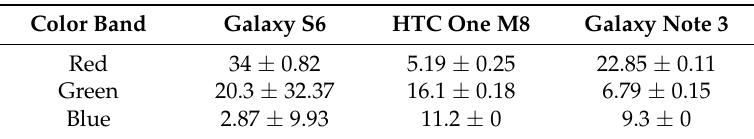
( c ) ( f ) Figure 15. Box plot of the average values of 𝑖 ∗ of the three color bands obtained from the 64 ROIs of Figure 15. Box plot of the average values of i ∗ of the three color bands obtained from the 64 ROIs of the the Galaxy S6 and the Galaxy Note 3 from 30 subjects with flash off: (a) Red (Galaxy S6); ( b ) Green Galaxy S6 and the Galaxy Note 3 from 30 subjects with flash off: ( a ) Red (Galaxy S6); ( b ) Green (Galaxy (Galaxy S6); ( c ) Blue (Galaxy S6); ( d ) Red (Galaxy Note 3); ( e ) Green (Galaxy Note 3); ( f ) Blue (Galaxy Note 3). Table 4. The average values of i ∗ of the three color bands obtained from 64 ROIs when the flashlight Table 4. The average values of 𝑖 ∗ of the three color bands obtained from 64 ROIs when the flashlight was was on.